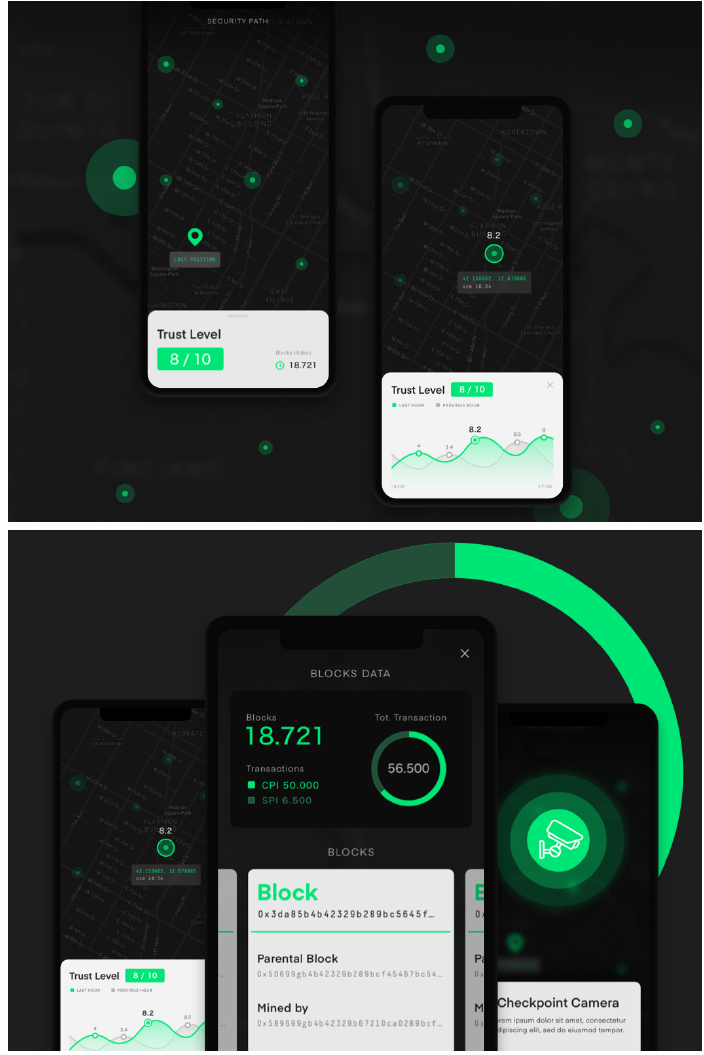
Figure 6. Mobile application built as a proof of